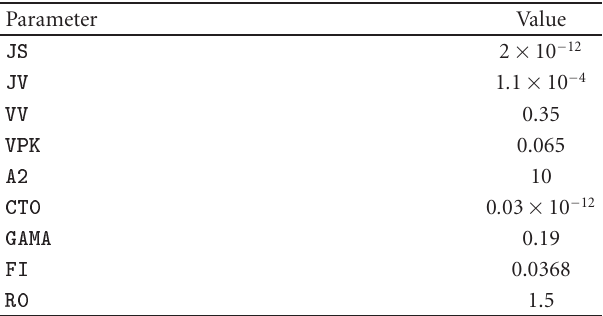
Figure 11: Simulated transient response of oscillator circuit. Table 2: Nondefault Esaki tunnel diode parameters used in transient